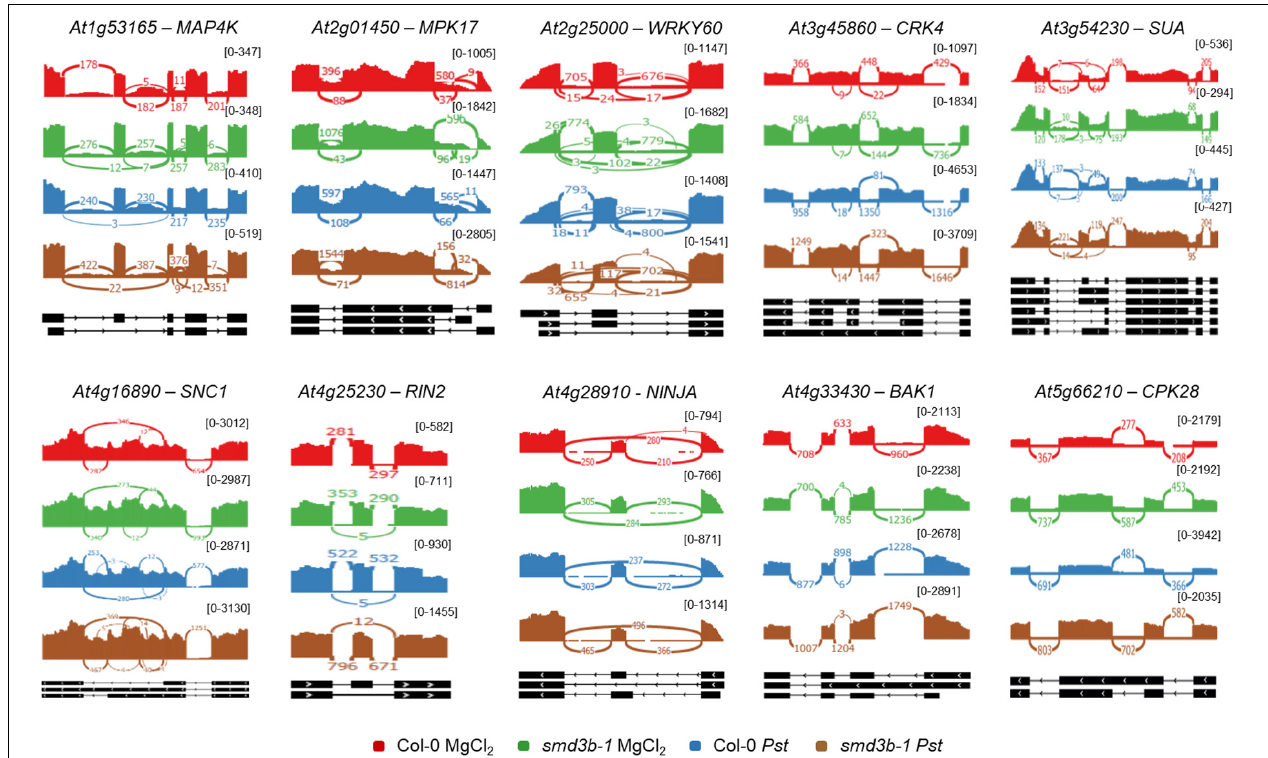
FIGURE 3 | Both Pst infection and smd3b-1 mutation affect alternative splicing (AS) events. Analysis of AS events for selected genes in control (MgCl 2 ) and infected (48 hpi; Pst ) Col-0 and smd3b-1 plants. AS events are significantly altered for genes involved in pathogen response. Sashimi plots were created from RNA-seq data using Integrative Genomics Viewer (IGV). The numbers in brackets are the range on the bar graph. Note differences in scales for each sashimi